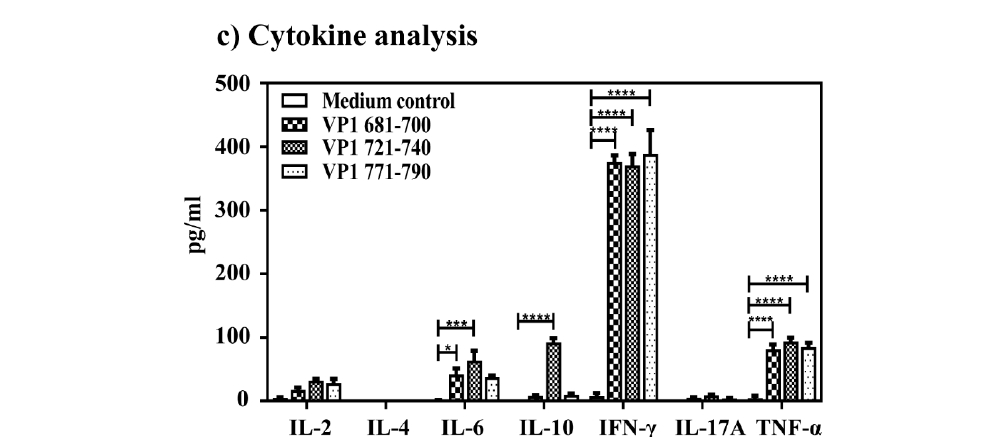
Figure 4. Evaluation of virus-specific T cell responses in infected animals. ( a ) Proliferative response. A / J mice were infected with CVB3, and at termination on day 21 post-infection, splenocytes were stimulated with or without VP1 681–700, VP1 721–740 and VP1 771–790 or control (RNase 43–56) for 2 days, and after pulsing with 3 [H] thymidine for 16 h, proliferative responses were measured as cpm. Data sets obtained from three individual experiments each involving six to eight mice are shown. ( b ) Antigen-specificity. Splenocytes from CVB3-infected mice were stimulated with indicated VP1 peptides and maintained in medium containing IL-2 for a week. Viable cells were harvested between days 7–10 post-stimulation and stained with indicated IA k / tetramers, anti-CD4 and 7-AAD. After acquiring the cells by flow cytometry, tetramer positive cells were analyzed in the live (7-AAD¯) CD4 subset using FlowJo software. Representative flow cytometric dot-plots for specific and control tetramers are shown in the left panel. Data sets obtained from three individual experiments, each involving six to eight mice are indicated in the right panel. RNase 43–56, control. ( c ) Cytokine analysis. Splenocytes from the CVB3-infected mice were stimulated with or without the indicated peptides. Supernatants collected on day 3 post-stimulation were analyzed for indicated cytokines by cytokine bead array. Data from three individual experiments, each involving six to eight mice, are shown. * p ≤ 0.05, ** p ≤ 0.01, *** p ≤ 0.001, and **** p ≤